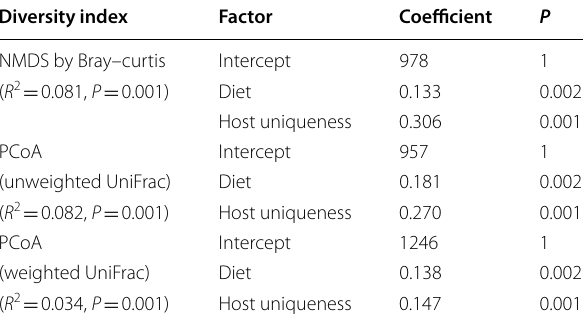
Table 2 Summary of the results on multiple regression on distance matrices (MRM) on the effect of diet and host uniqueness on gut microbe community structure